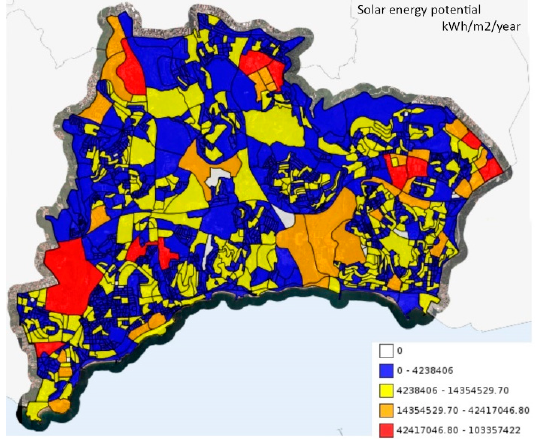
Figure 8. Potential of solar energy production on building roofs.